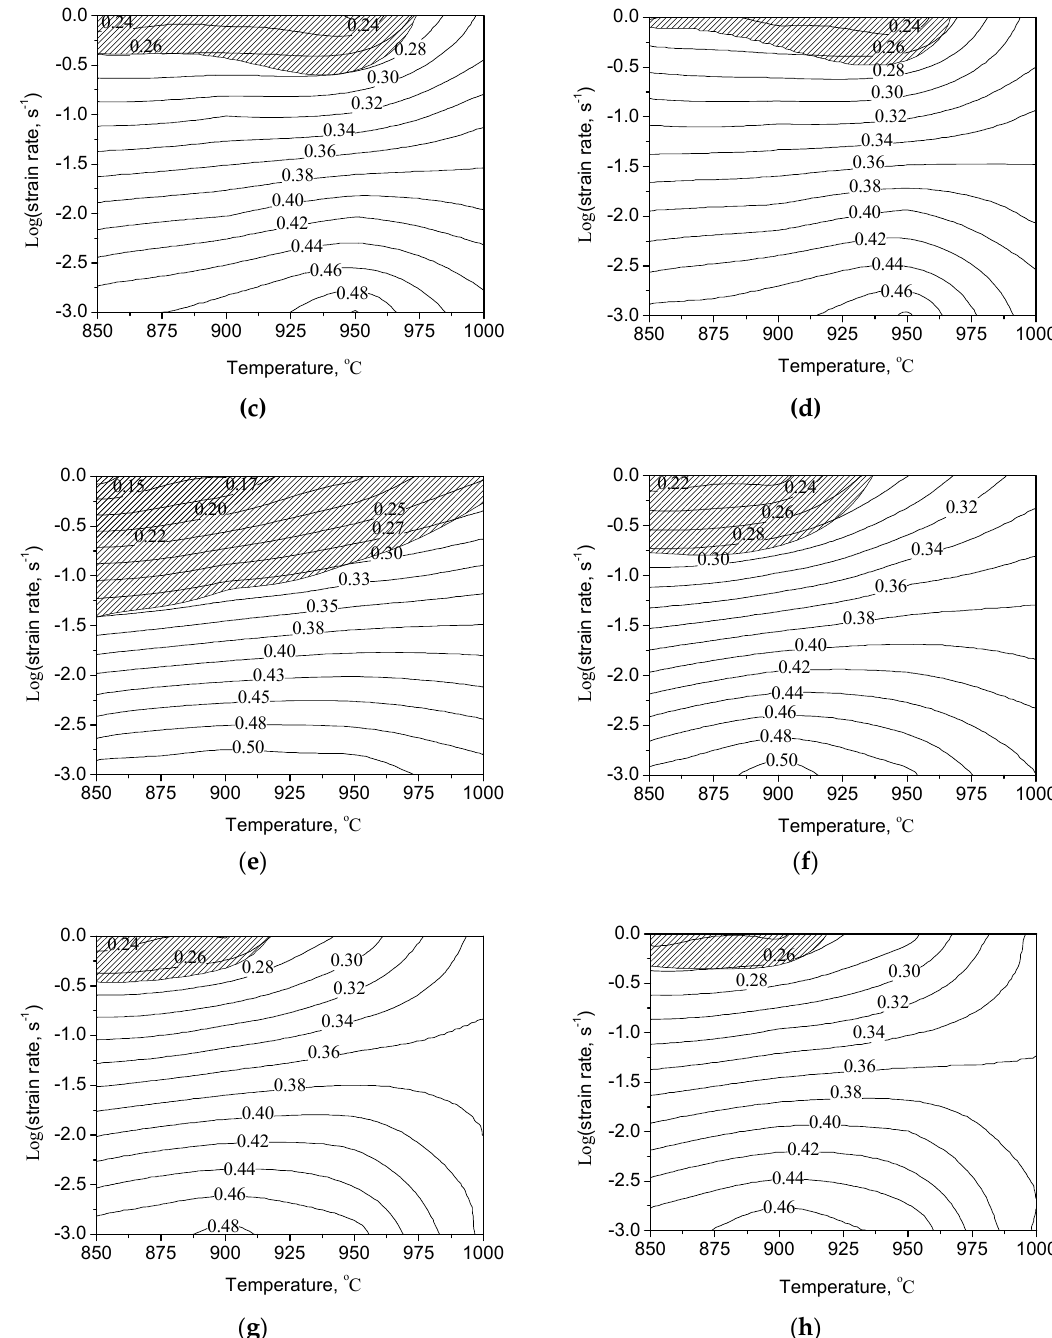
Figure 8. Processing maps of the coarse-grained ( a – d ) and fine-grained ( e – h ) alloys at true strains of (( a ) and ( e )) 0.2, (( b ) and ( f )) 0.5, (( c ) and ( g )) 0.7, and (( d ) and ( h )) 0.8.